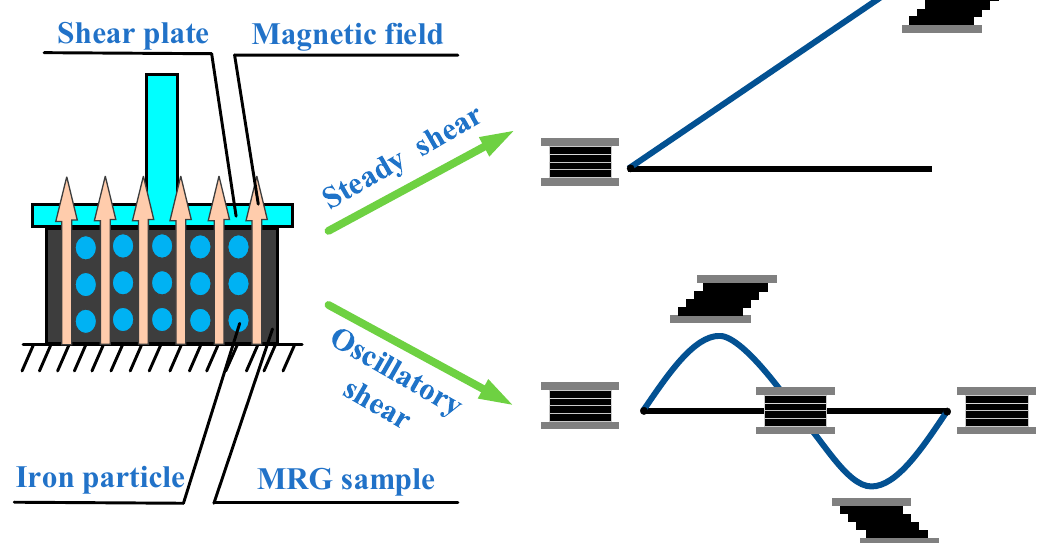
Figure 2. Schematic diagram of test principle.